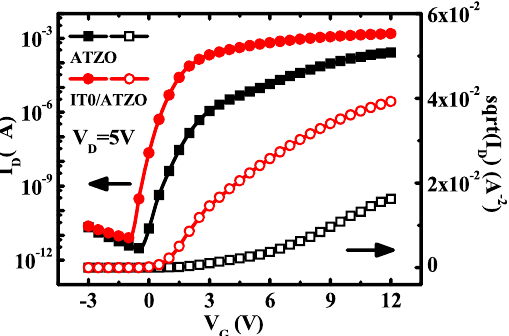
Figure 3. Transfer characteristics of the single-channel ATZO and double-channel ITO/ATZO TFTs. V D = 5 V.